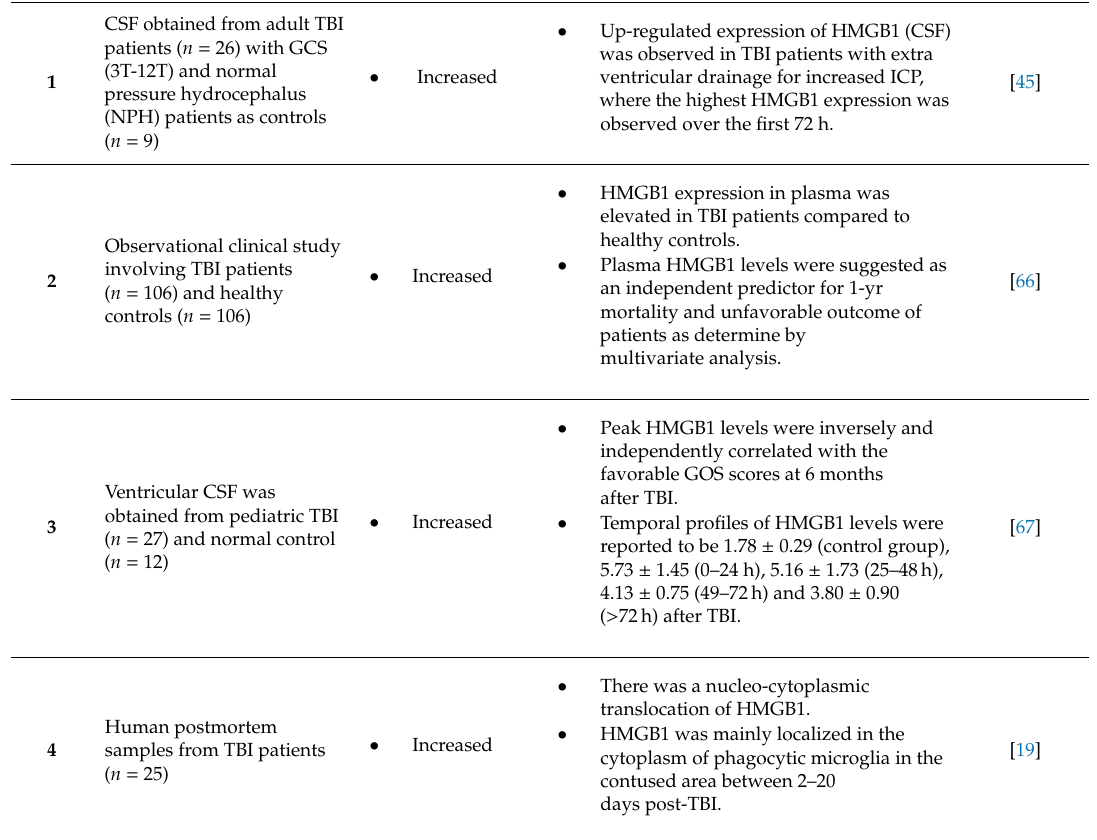
Table 1. Summaries of findings reporting biomarker potential of HMGB1 to predict outcome after TBI.